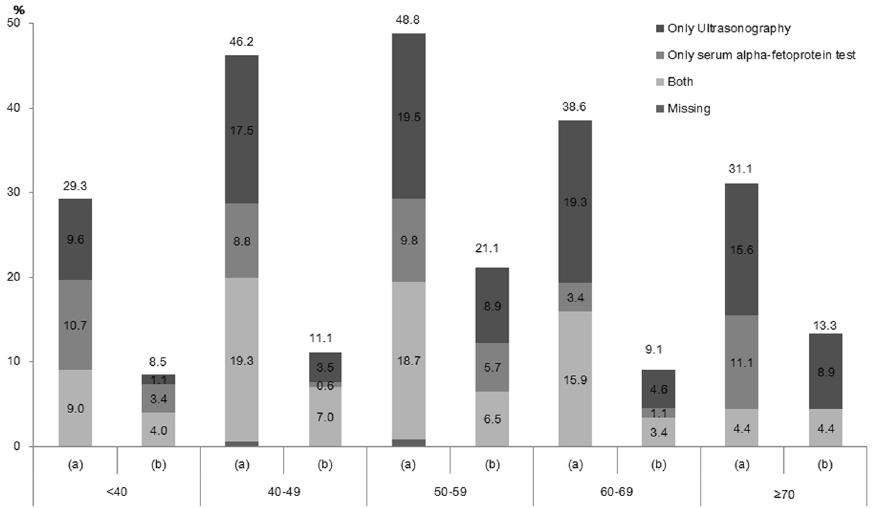
Figure 2. Lifetime (a) and regular (b) liver cancer screening rates according to screening method in high risk population of liver cancer by age. Lifetime liver cancer screening rate, regular liver cancer screening rate, and complete liver cancer screening in the entire study sample were 39.6%, 12.3%, and 14.6%, respectively.